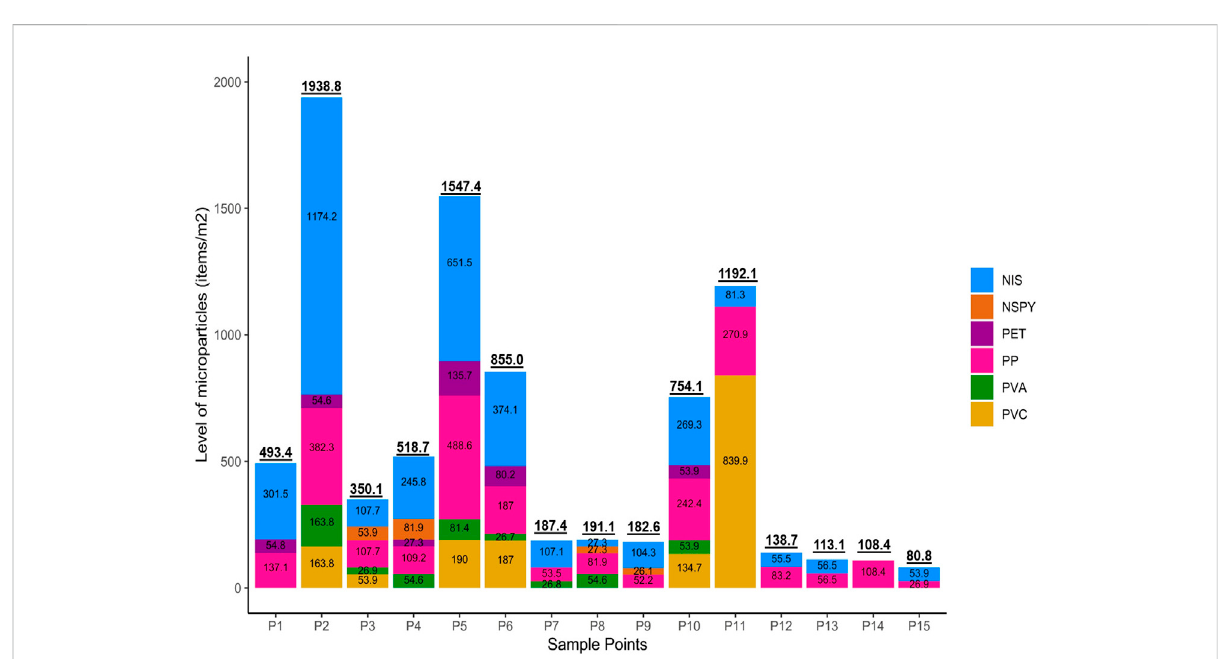
FIGURE 2 Microplastic composition at each sampling site. NIS – Non-identi fi ed synthetic; NPSY – Ink particles; PET - Polyethylene terephthalate; PP – Polypropylene; PVA - Polyvinyl alcohol; PVC - Polyvinyl Chloride. The numbers in the bars are the level of a speci fi c type of microparticle. The numbersontopofthebarsarethetotallevelofmicroplasticatthatsite.SitesonetofourarelocatedinthePlateauhighlands.Sites5to15arelocated in the Pantanal fl oodplain (See Figure